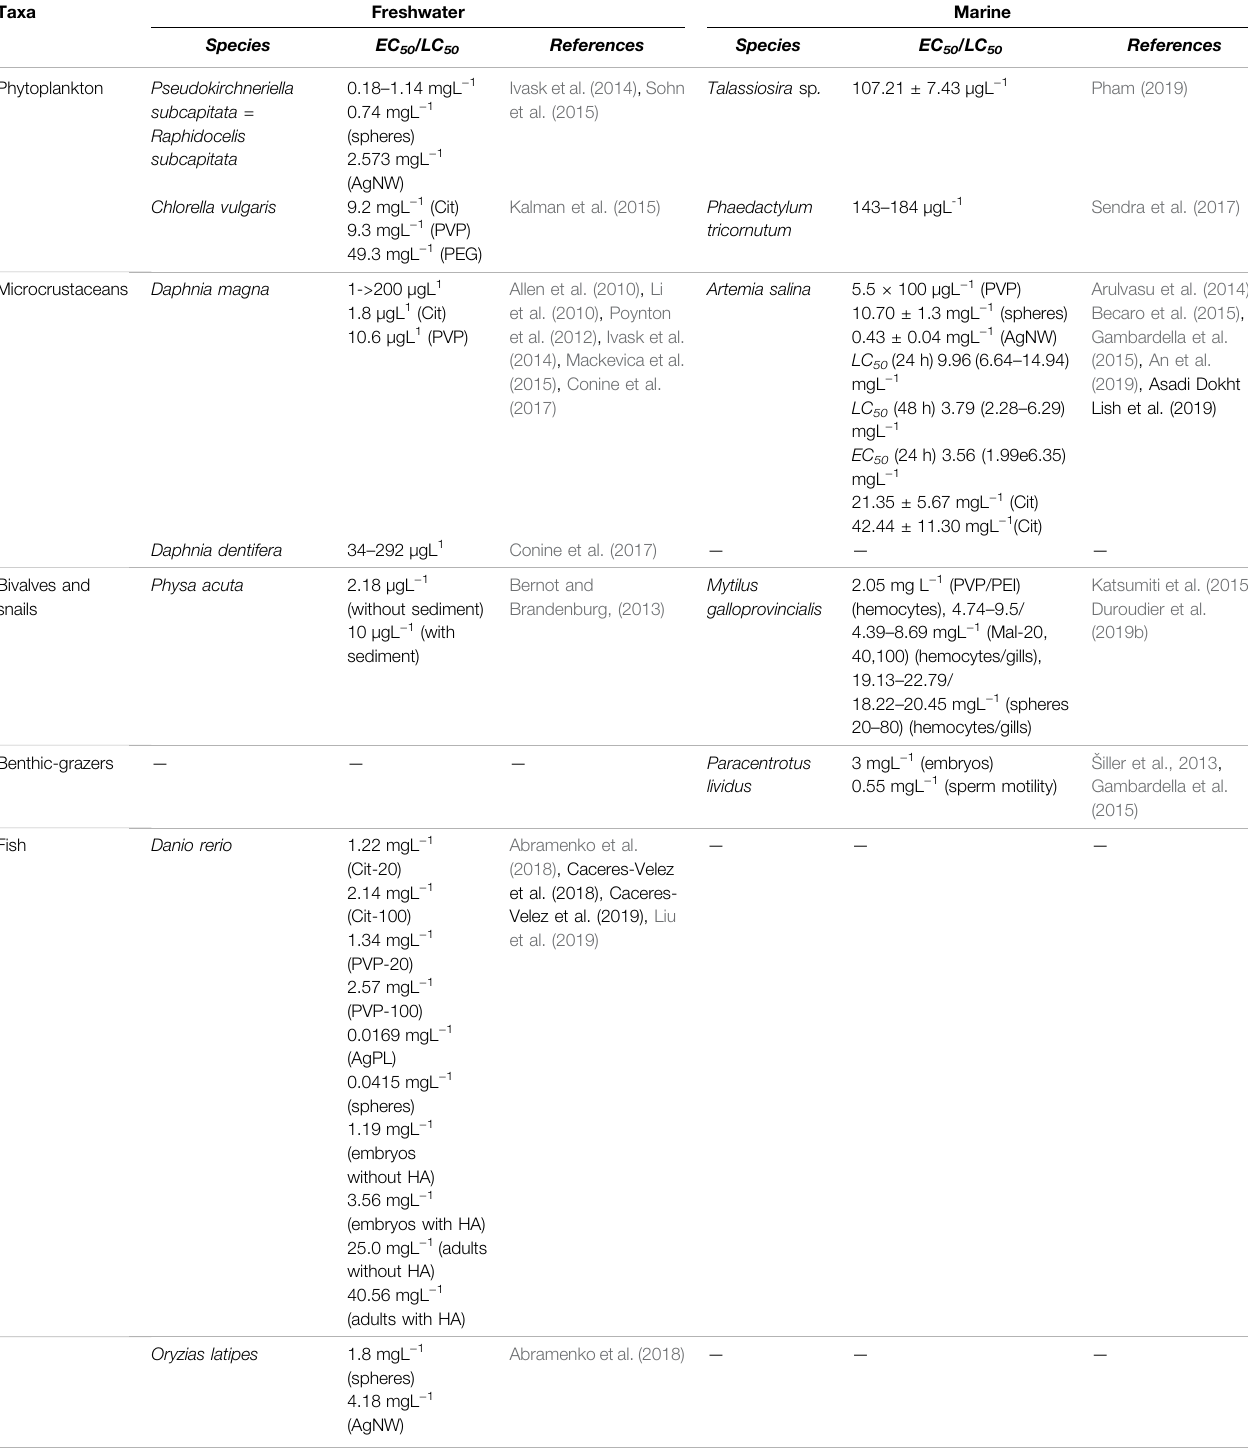
TABLE 1 | Comparison among EC 50 and LC 50 values calculated for AgNPs in freshwater and marine